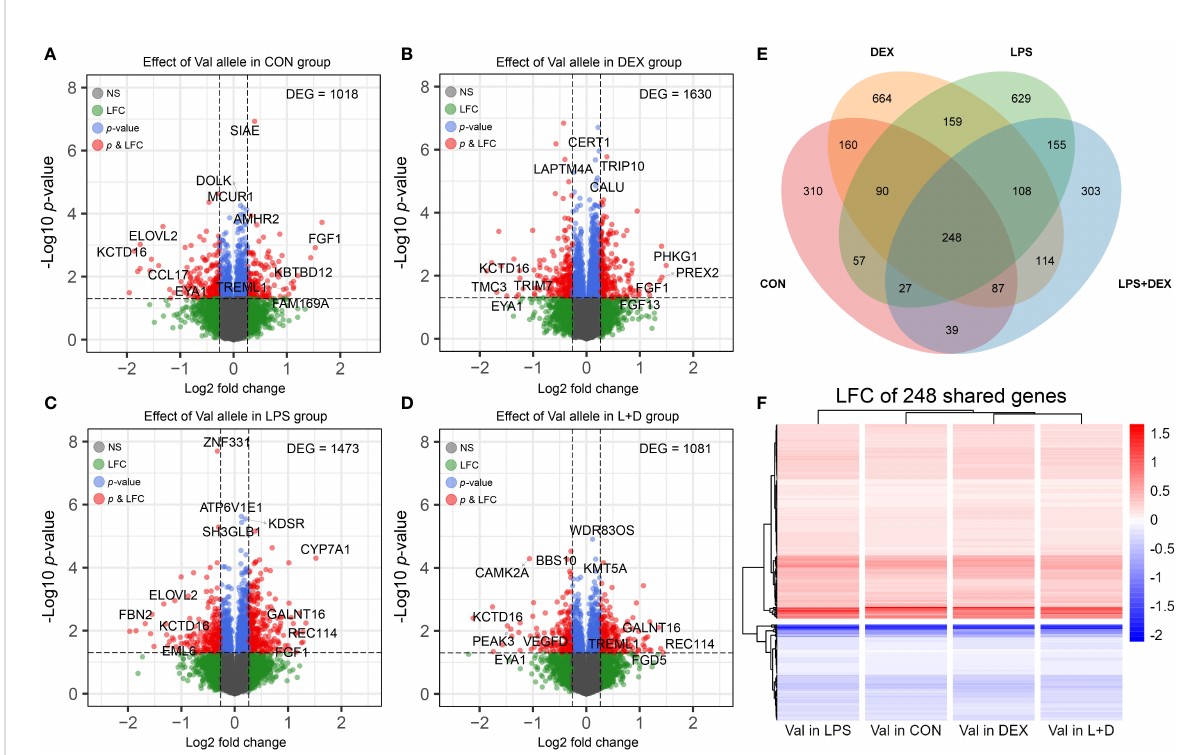
FIGURE 1 Differential expression analysis. (A-D) Volcano plots of differentially expressed genes (DEGs) induced by dosage of the Val allele in (A) CON, (B) DEX, (C) LPS, and (D) LPS+DEX groups. The top four most signi fi cant ( p -value) and most up and down regulated DEGs (LFC) were displayed. (E) Venn diagram illustrating shared and unique DEGs induced by dosage of the Val allele among four treatment groups. (F) Heatmap constructed based on LFC of Val DEGs shared by four treatment groups. Val, Valine; CON, control; DEX: dexamethasone; LPS, lipopolysaccharide; LFC, log2 fold